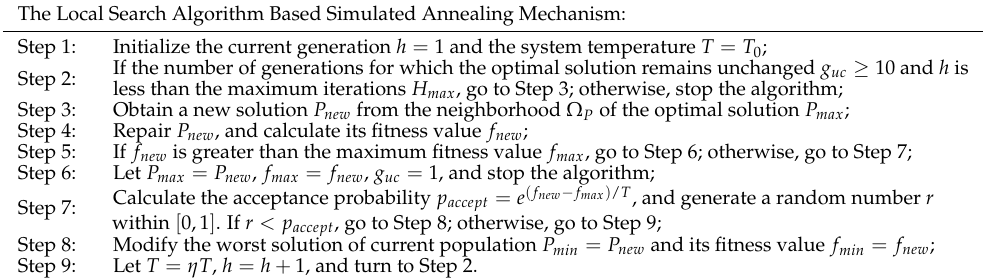
Algorithm 3 . Steps of the local search algorithm based on simulated annealing mechanism (Source: compiled by